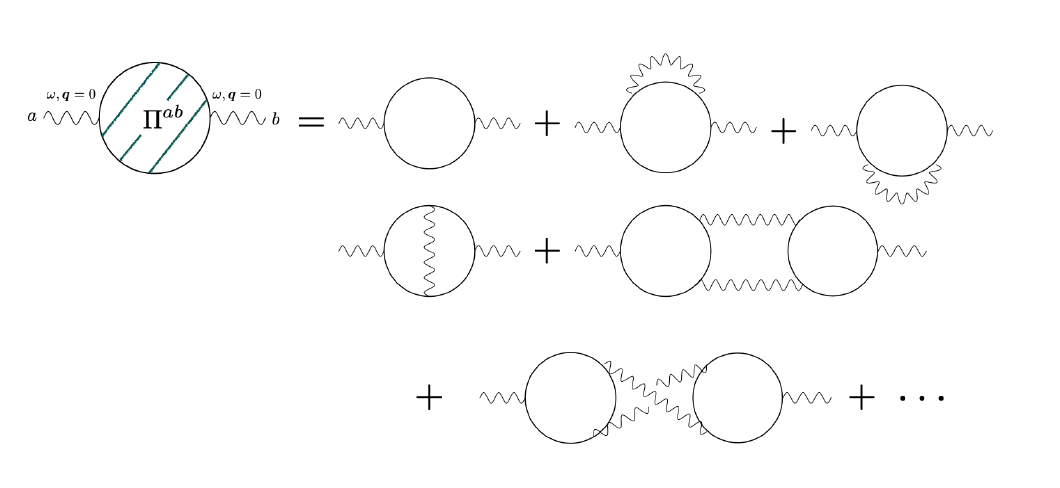
Figure 2: A sample of the Feynman diagrams that contribute to the boson self energy, Π ab ( ω , q = 0 ) , where solid and wavy lines denote bare fermion and boson propa- gators, respectively. The boson self energy is naïvely constrained by (intra-patch) charge conservation alone, but the presence of the anomaly deforms this